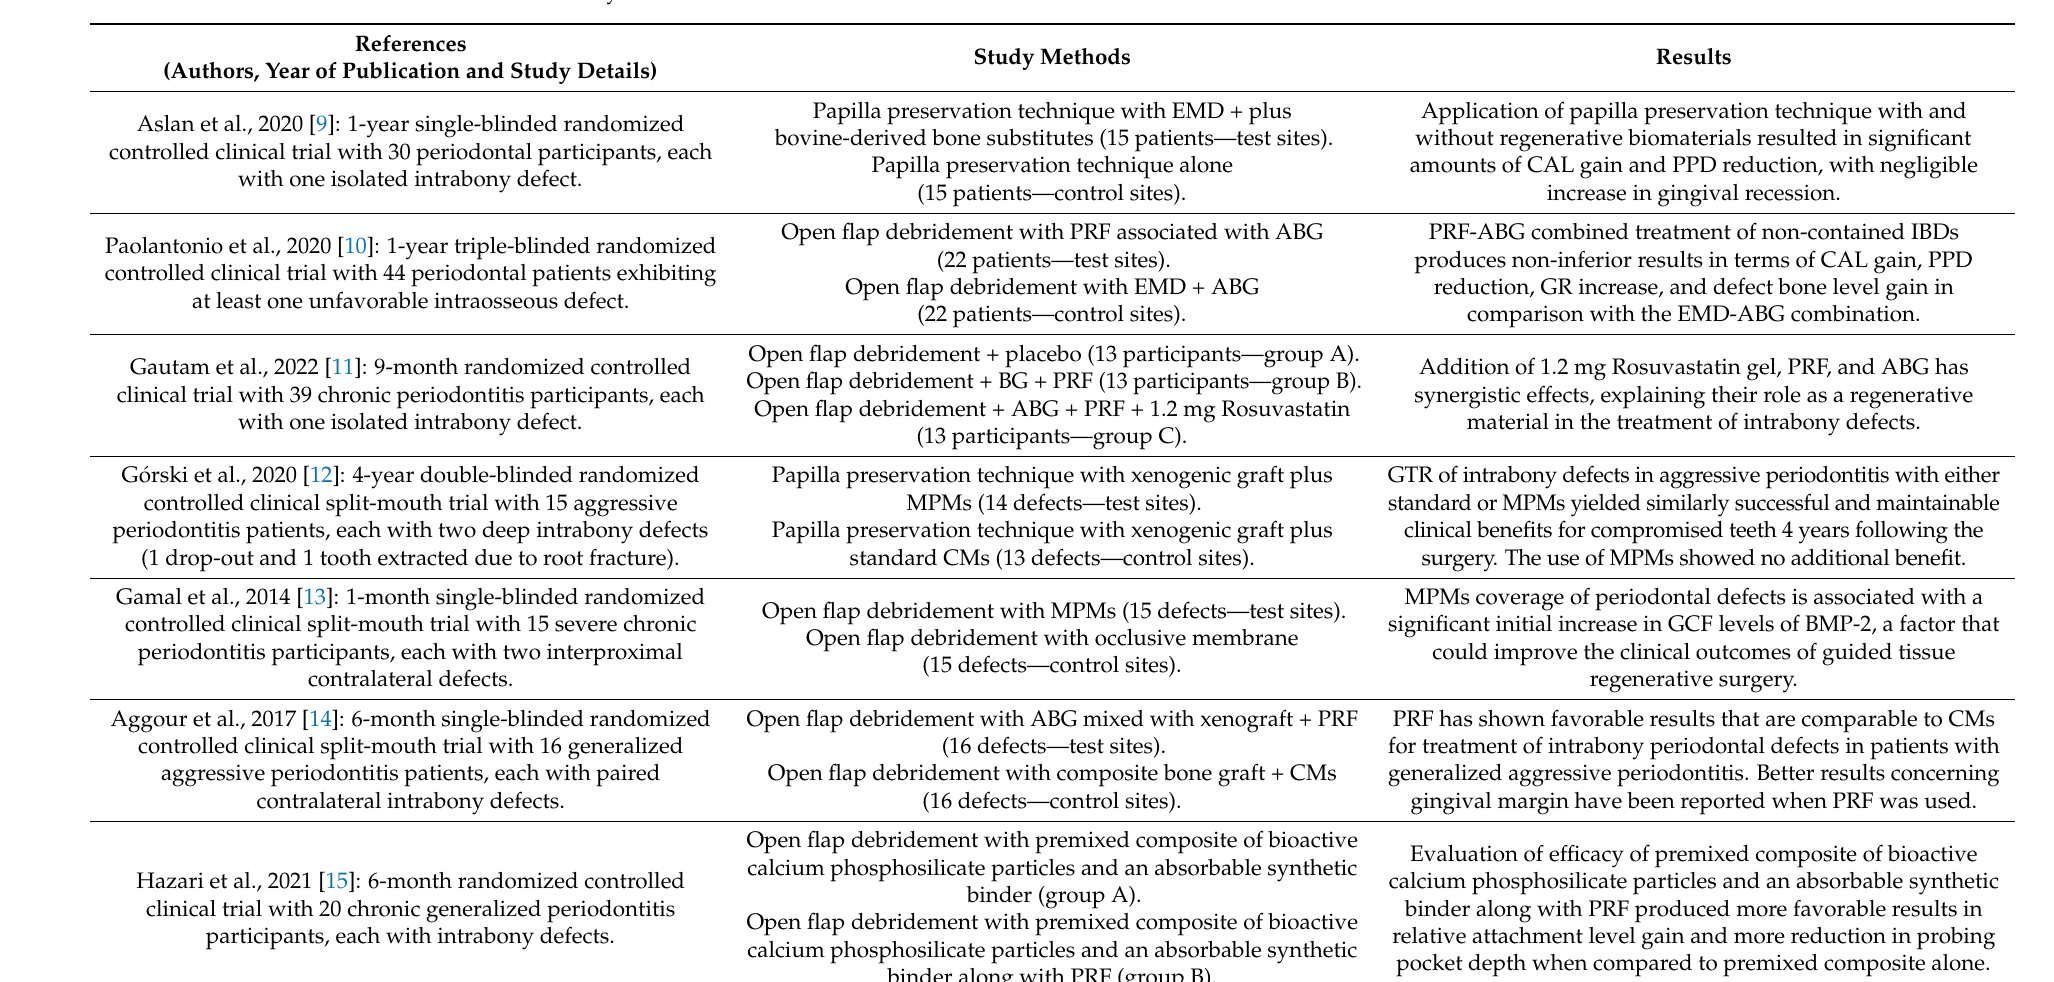
Table 2. A summary of the results of studies included in this